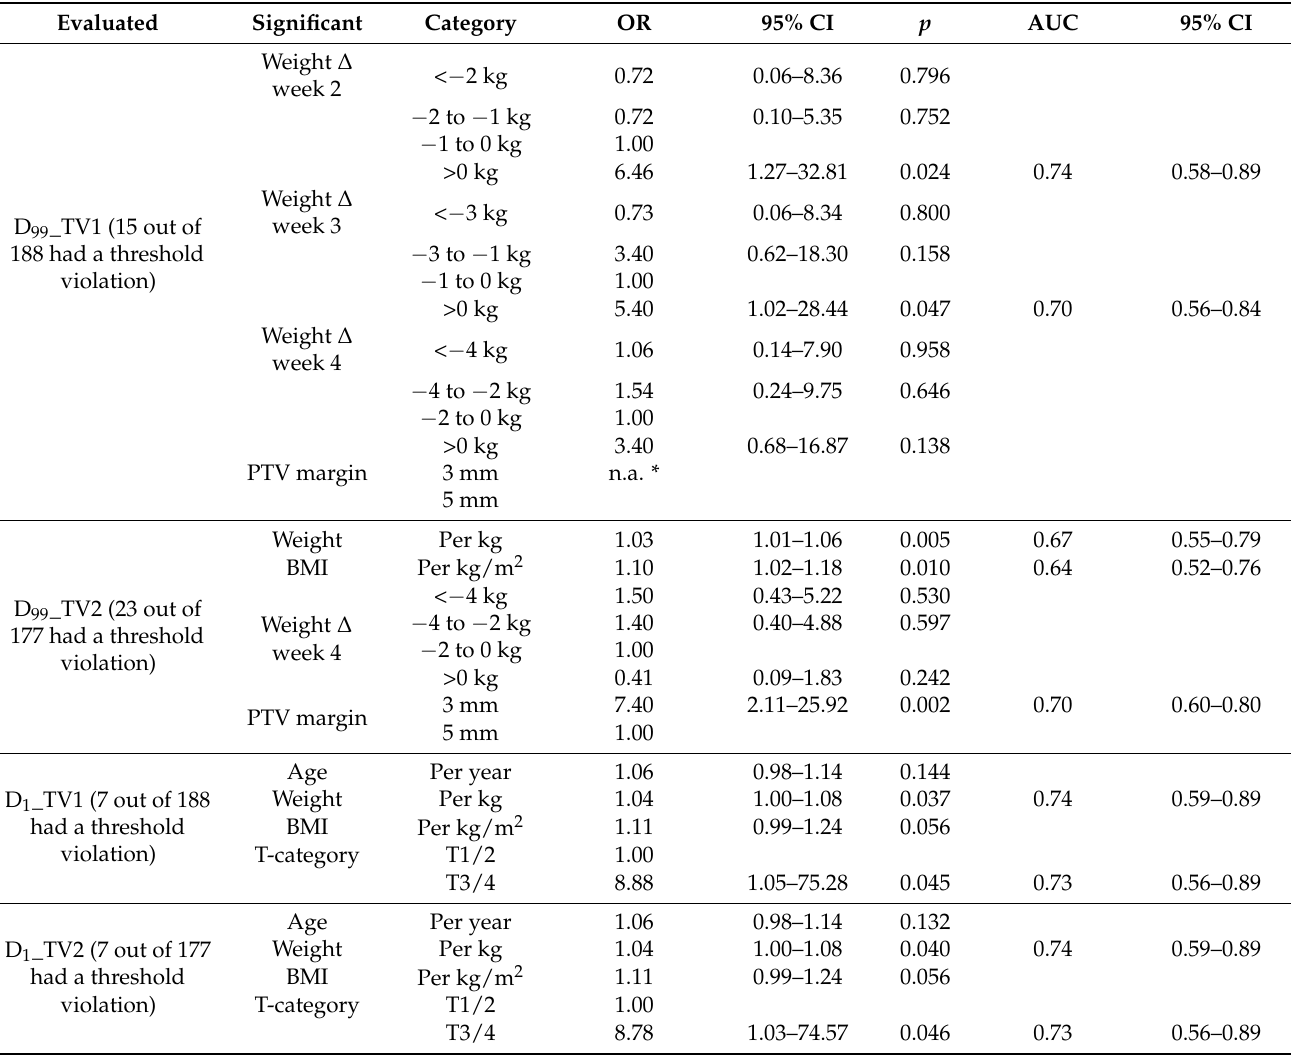
Figure 3. Mean weight loss comparing all patients to patients with dose deterioration are shown in Table 2. Binary logistic regression analyses to identify significant factors for dose deterioration > 1 Gy.